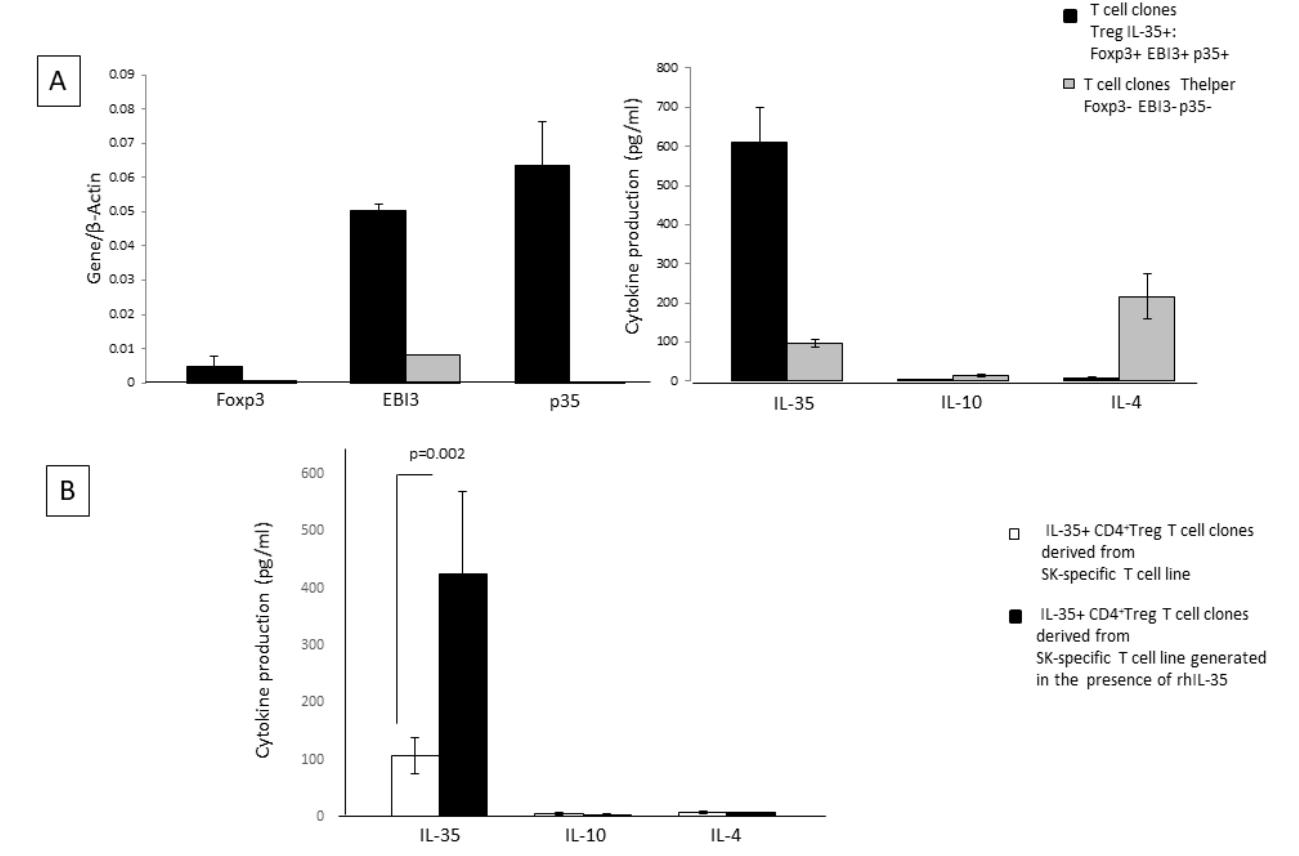
Figure 3. rhIL-35 favors the development of Foxp3 Treg cells producing IL-35 in SK-specific CD4+ T-cell lines. T-cell blasts from SK-specific T-cell lines generated in the absence or in the presence of rhIL-35 (300 pg/mL) derived from the peripheral blood of two different donors were cloned under limiting dilution conditions. ( A ) The derived CD4+ T-cell clones were analyzed with RT-PCR for their ability to express mRNA for Foxp3, EBI3, and p35 and for the ability to produce IL-35, IL-4, and IL-10 in response to PMA plus anti-CD3 mAb. ( B ) The Treg-type clones expressing Foxp3 derived from the SK-specific T-cell lines generated with rhIL-35 and without rhIL-35 were assessed for IL-35, IL-10, and IL-4 production in response to PMA plus anti-CD3 mAb